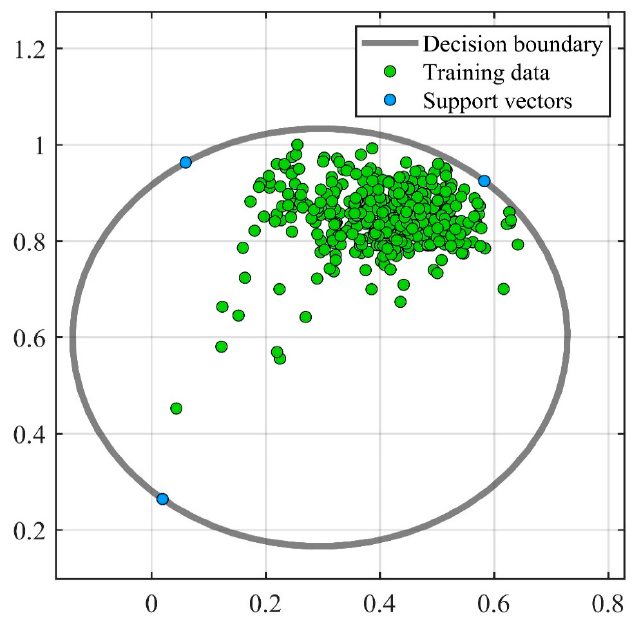
Figure 11. Identifying the results of damage.